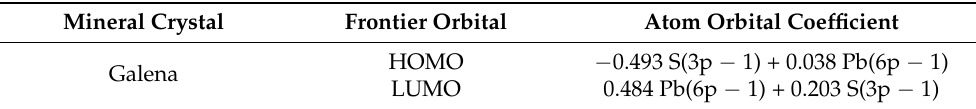
Table 5. Frontier orbital and atom orbital coefficients of galena.